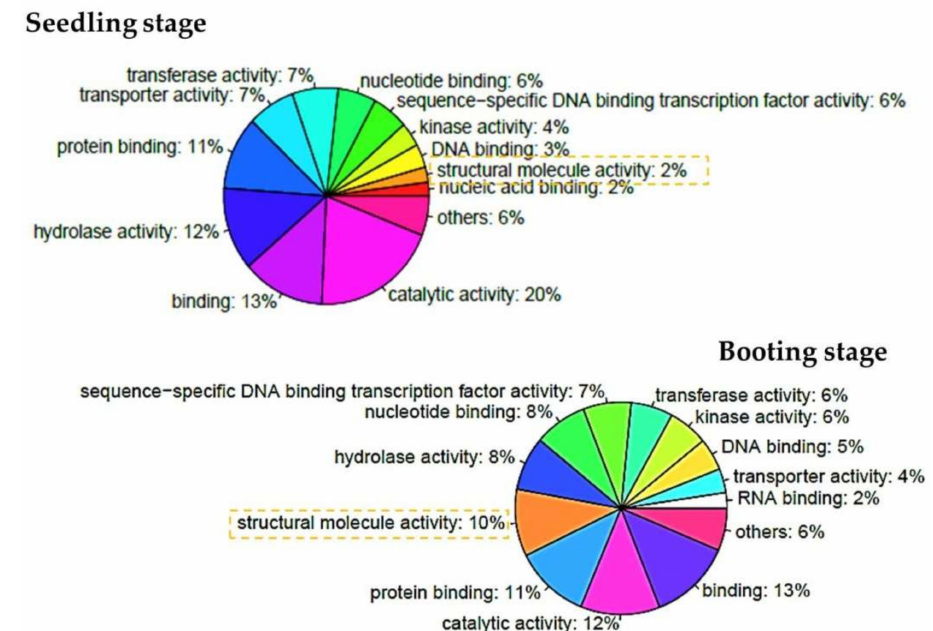
Figure 3. Gene ontology classification of differentially expressed genes among the molecular functions. The top-left of the pie chart represents the gene proportion of each function during the seedling stage. The bottom-right of the pie chart represents the gene proportion of each function during the booting stage.